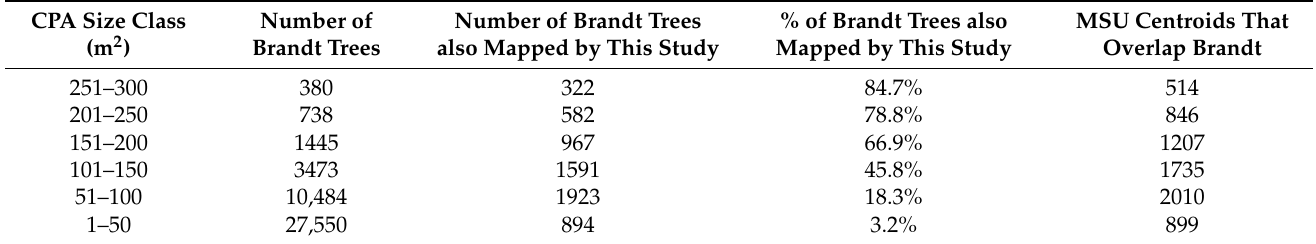
Table 4. Comparison of Brandt with this study.